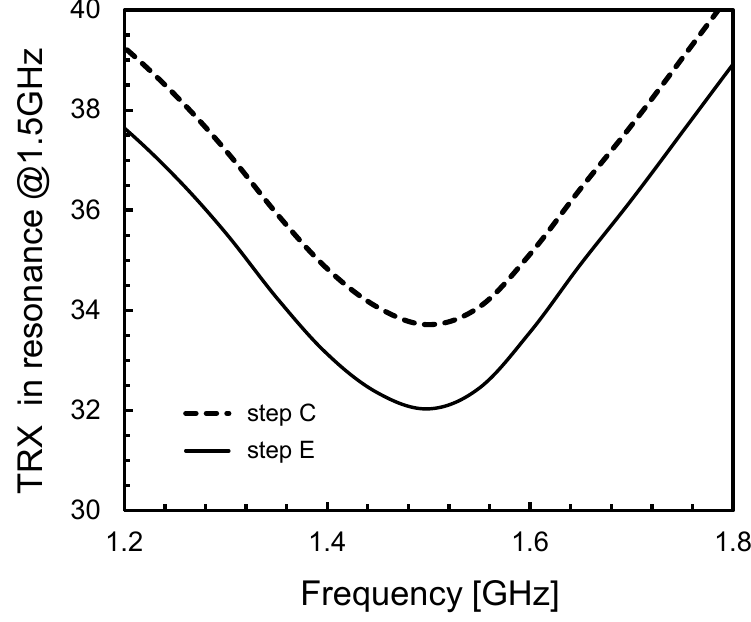
Figure 17. TRX in open circuit and resonance condition at 1.5 GHz. For the sake of completeness, Figure 18 depicts the magnetic field distribution at the operative frequency (i.e., 1.5 GHz) for the TX/RX micro-antenna configuration in design step E, obtained by means of 3D EM simulations with a TX antenna differential